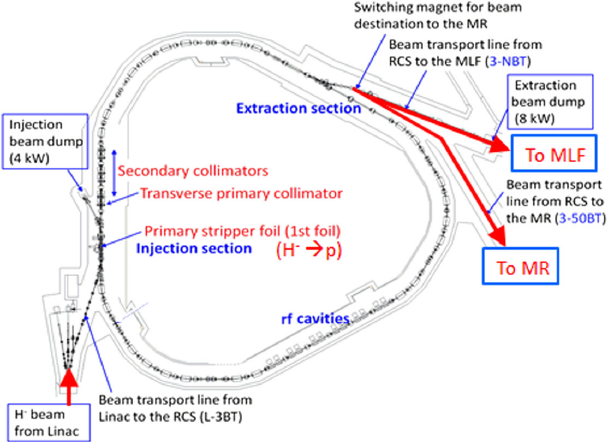
FIG. 1. A schematic view of the 3-GeV RCS at J-PARC. The 400 MeV injection H − beam from the linac is stripped to p by the primary stripper foil installed at the middle of charge-exchange injection section. The p are injected into the RCS, accelerated up to 3 GeV, and simultaneously delivered to the MLF and